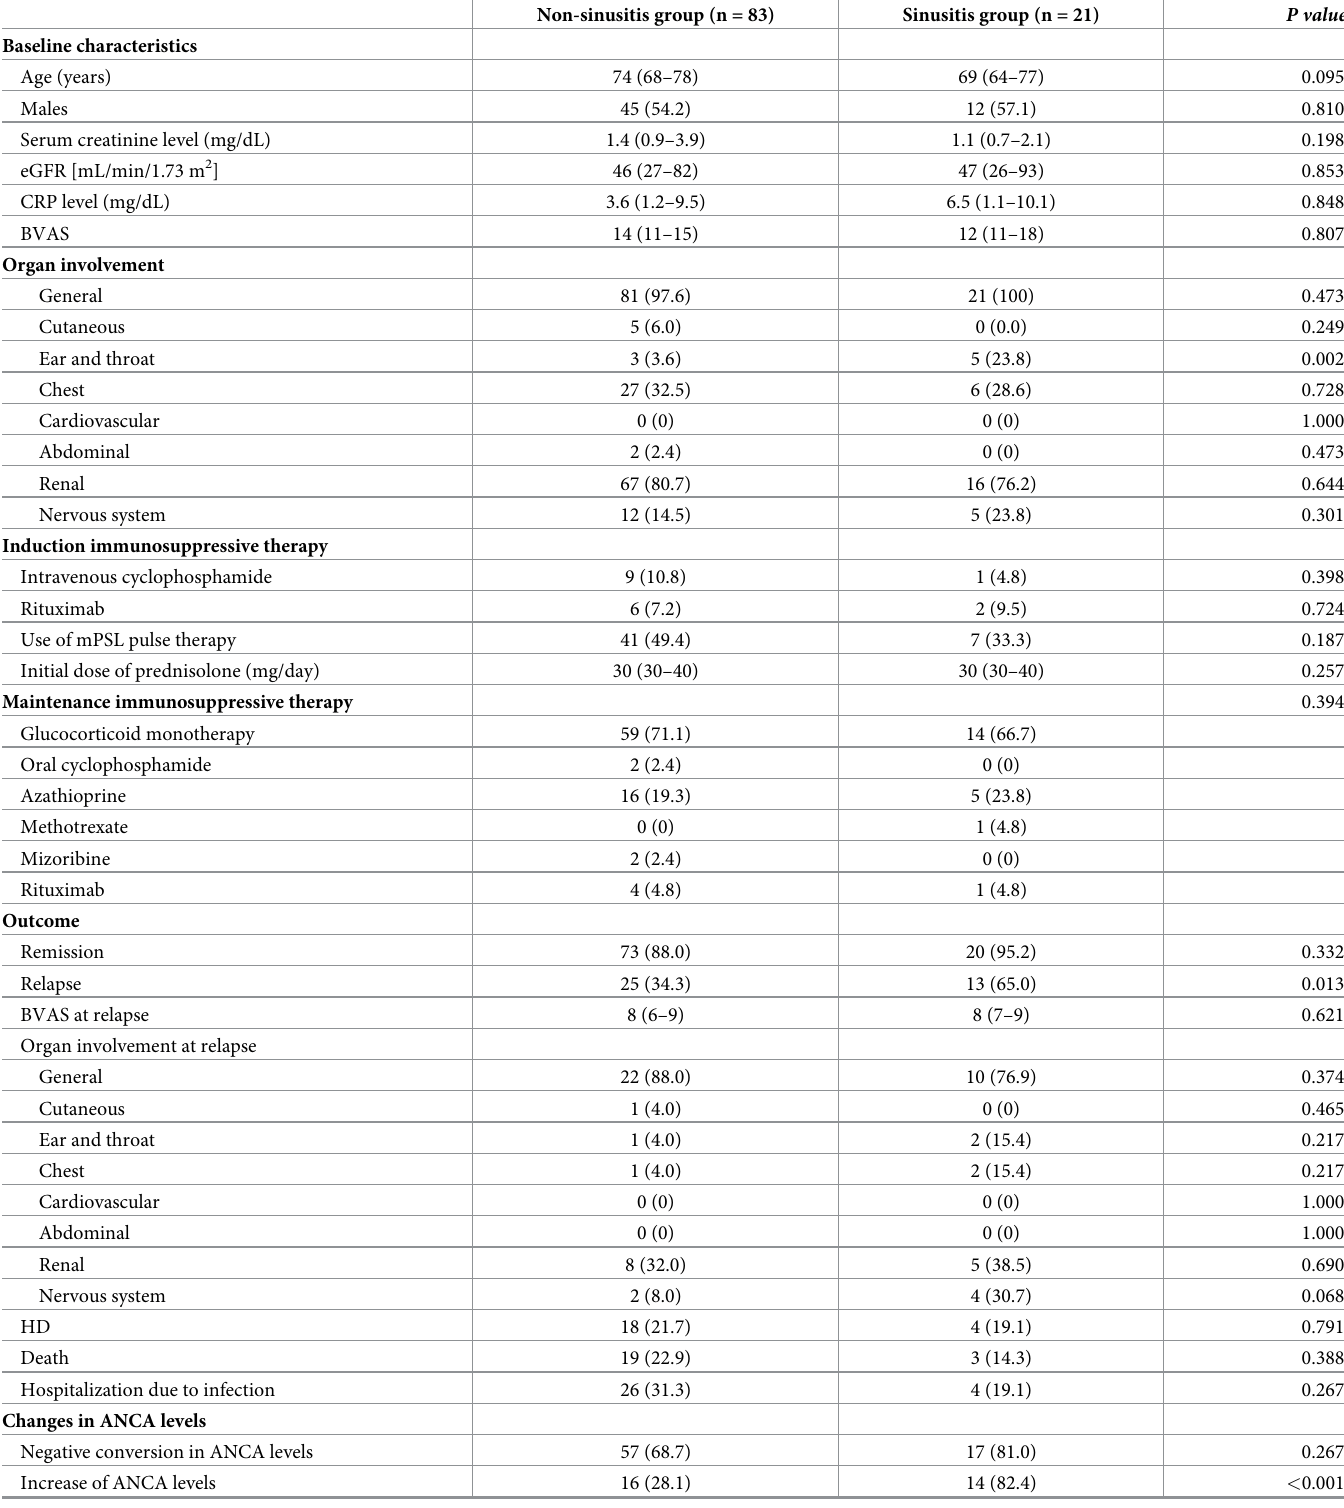
Table 1. Clinical characteristics of 104 patients with MPO-ANCA-positive